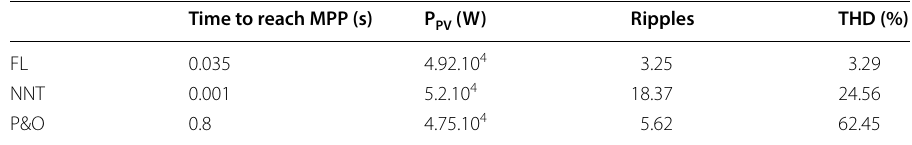
1000 W/m 2 and T =